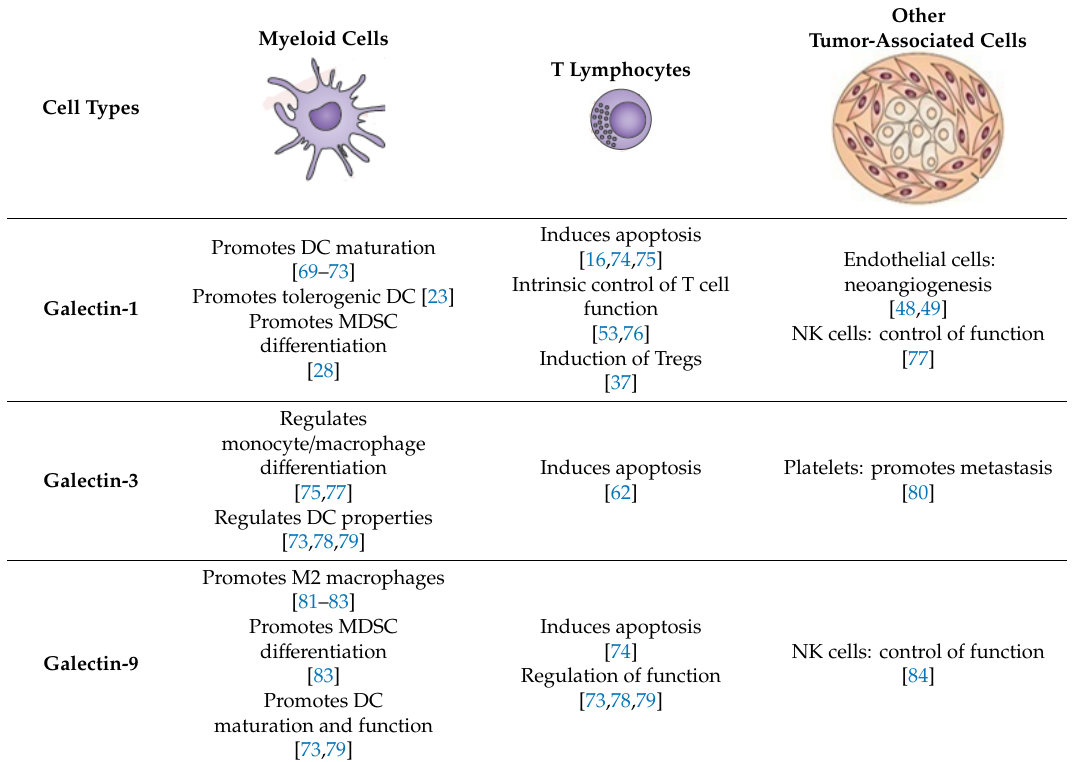
Table 1. Described functions for the three main galectins (Gals) on immune cells in the